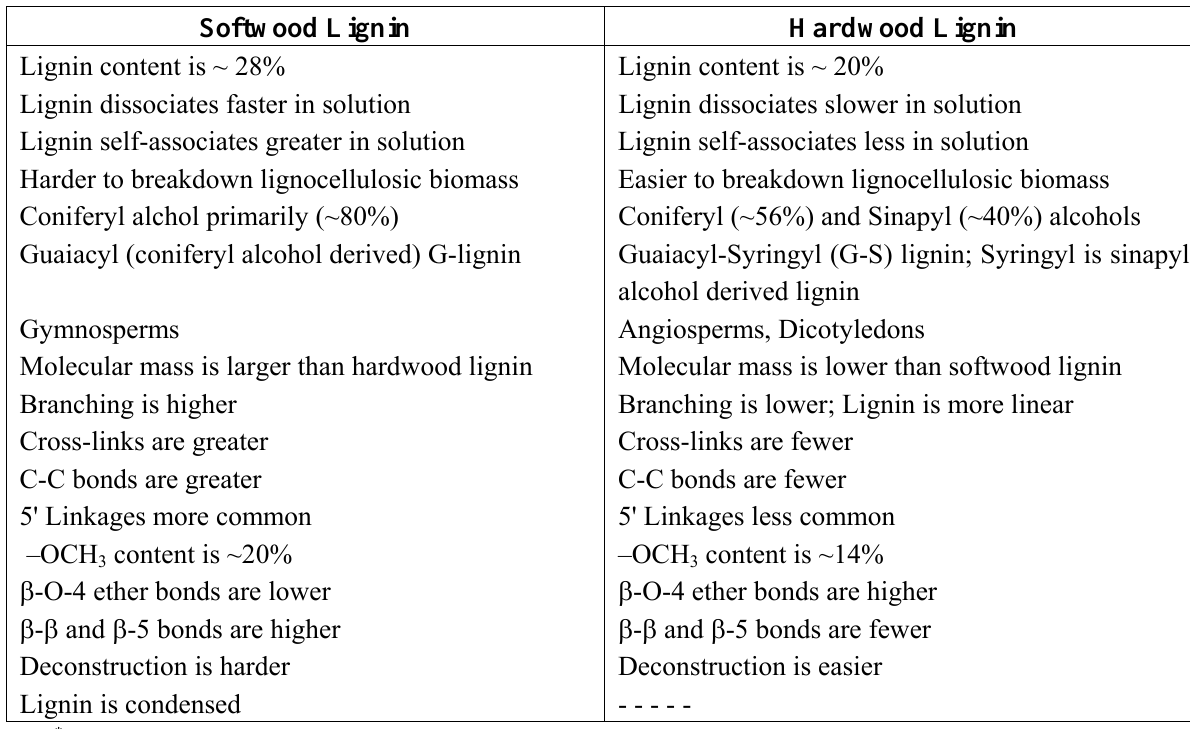
Table 2. Comparative properties of softwood and hardwood lignins.